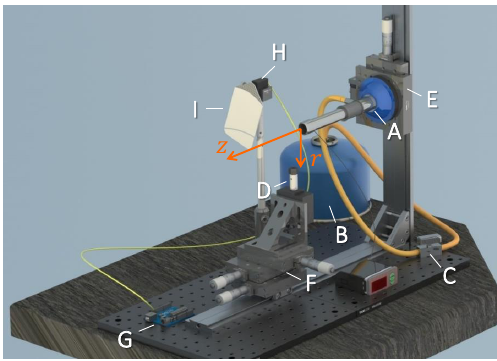
Figure 14. Fire-shaping setup: (A) Bunsen burner, (B) gas bottle, (C) gas valve, (D) collect and chuck holder, (E) vertical translation stage, (F) horizontal two-axis translation stage, (G) Arduino board, (H) servomotor and (I) ceramic